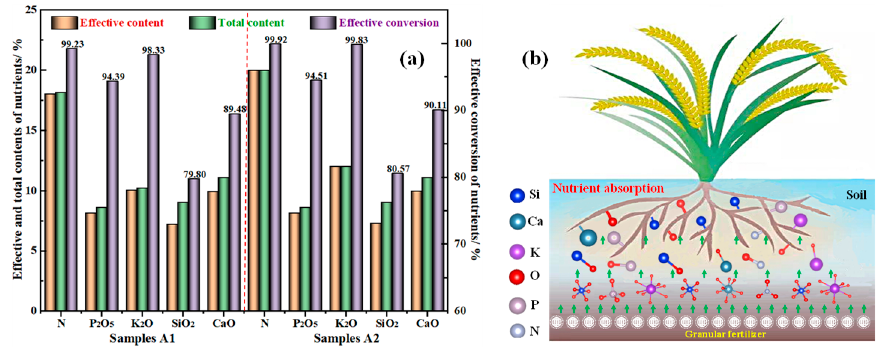
Figure 9. ( a ) Effective conversion of the nutrients in the prepared rice fertilizer (dotted line left is Sample A1, and right is Sample A2); ( b ) Schematic diagram of absorption by the rice roots.